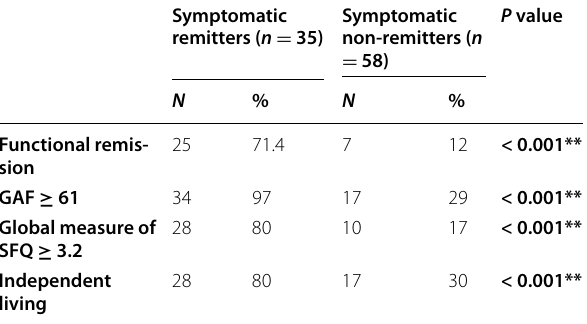
Table 3 Comparison between symptomatic remitters and non- remitters as regard functional